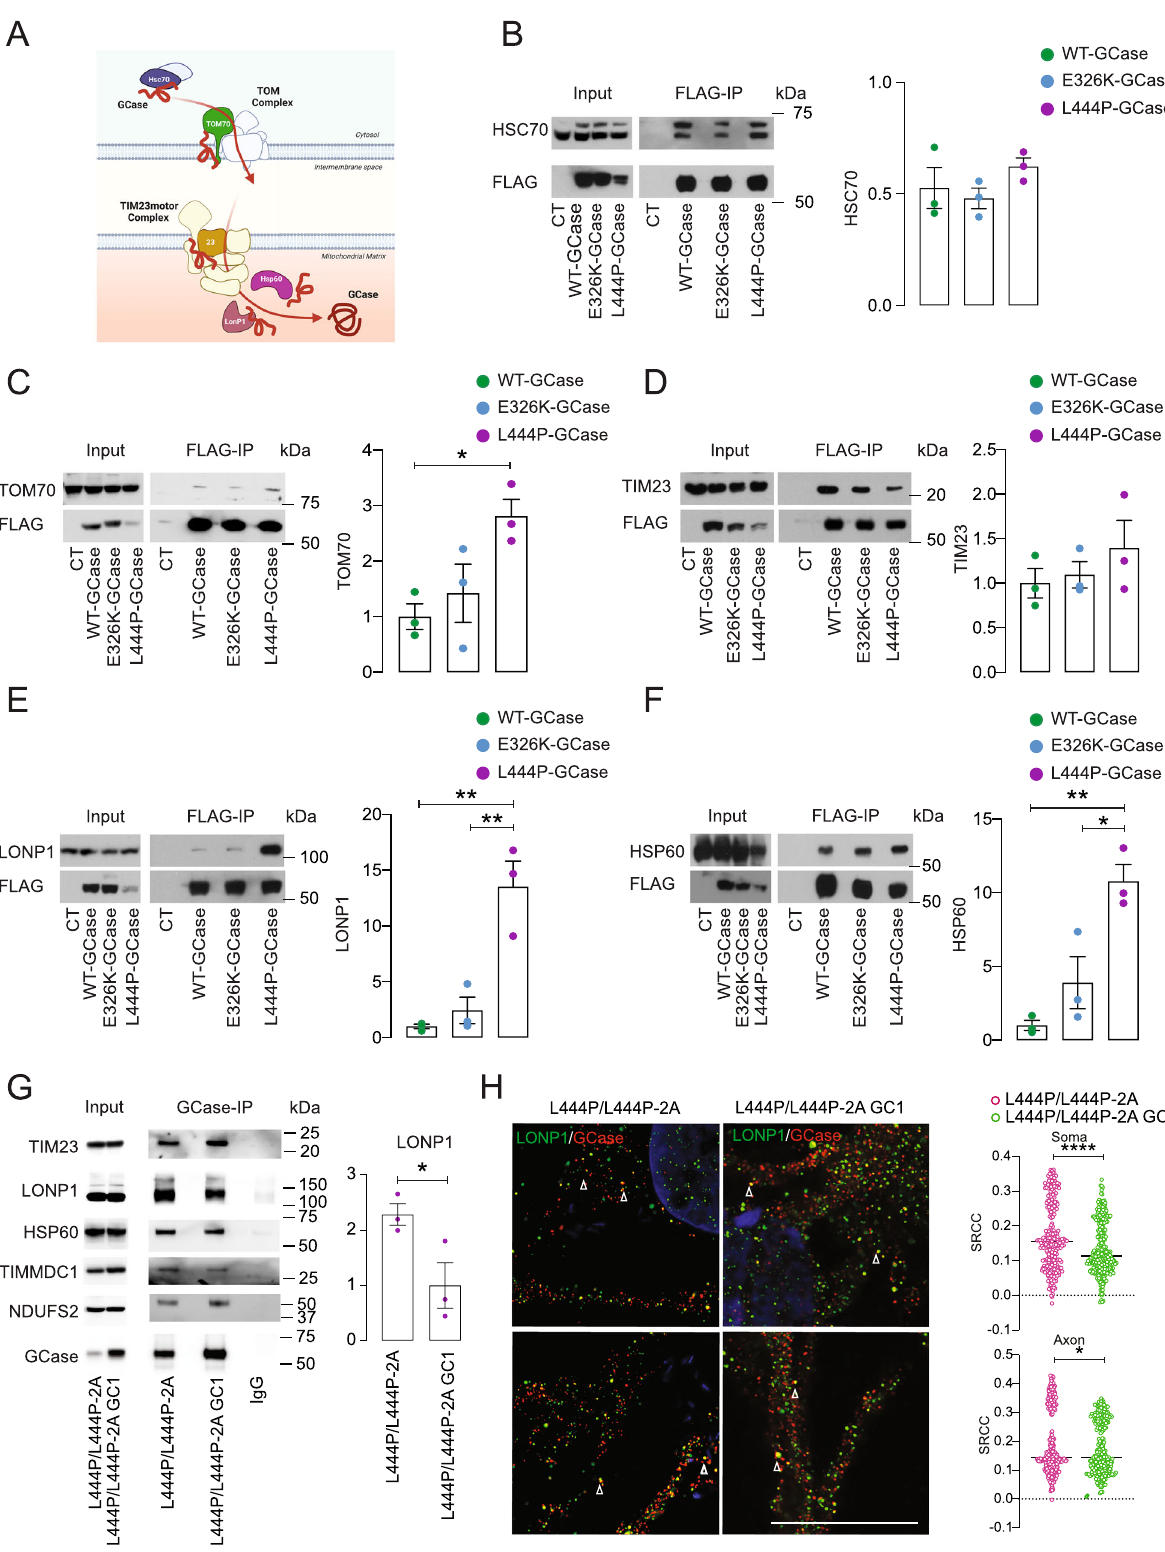
SYP , and VAMP2 ) (Supplementary Fig. 12A, B). Synaptic transcription factor genes were highly expressed within the neuronal clusters (Fig. 6D and SupplementaryFig. 12C). Differentialgene expression and pathway analysis of neuronal clusters in scRNA-seq data revealed enrichment of metabolic pathways across isogenic pairs, with a stronger impact on mitochondrial ATP-related pathways in the severe